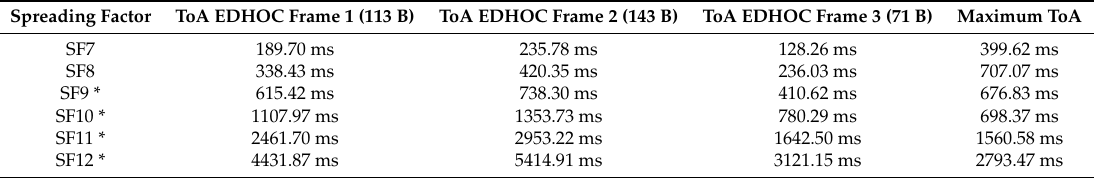
Table 1. Time-on-Air (ToA) of EDHOC messages and maximum admissible transmission times for different LoRa SF